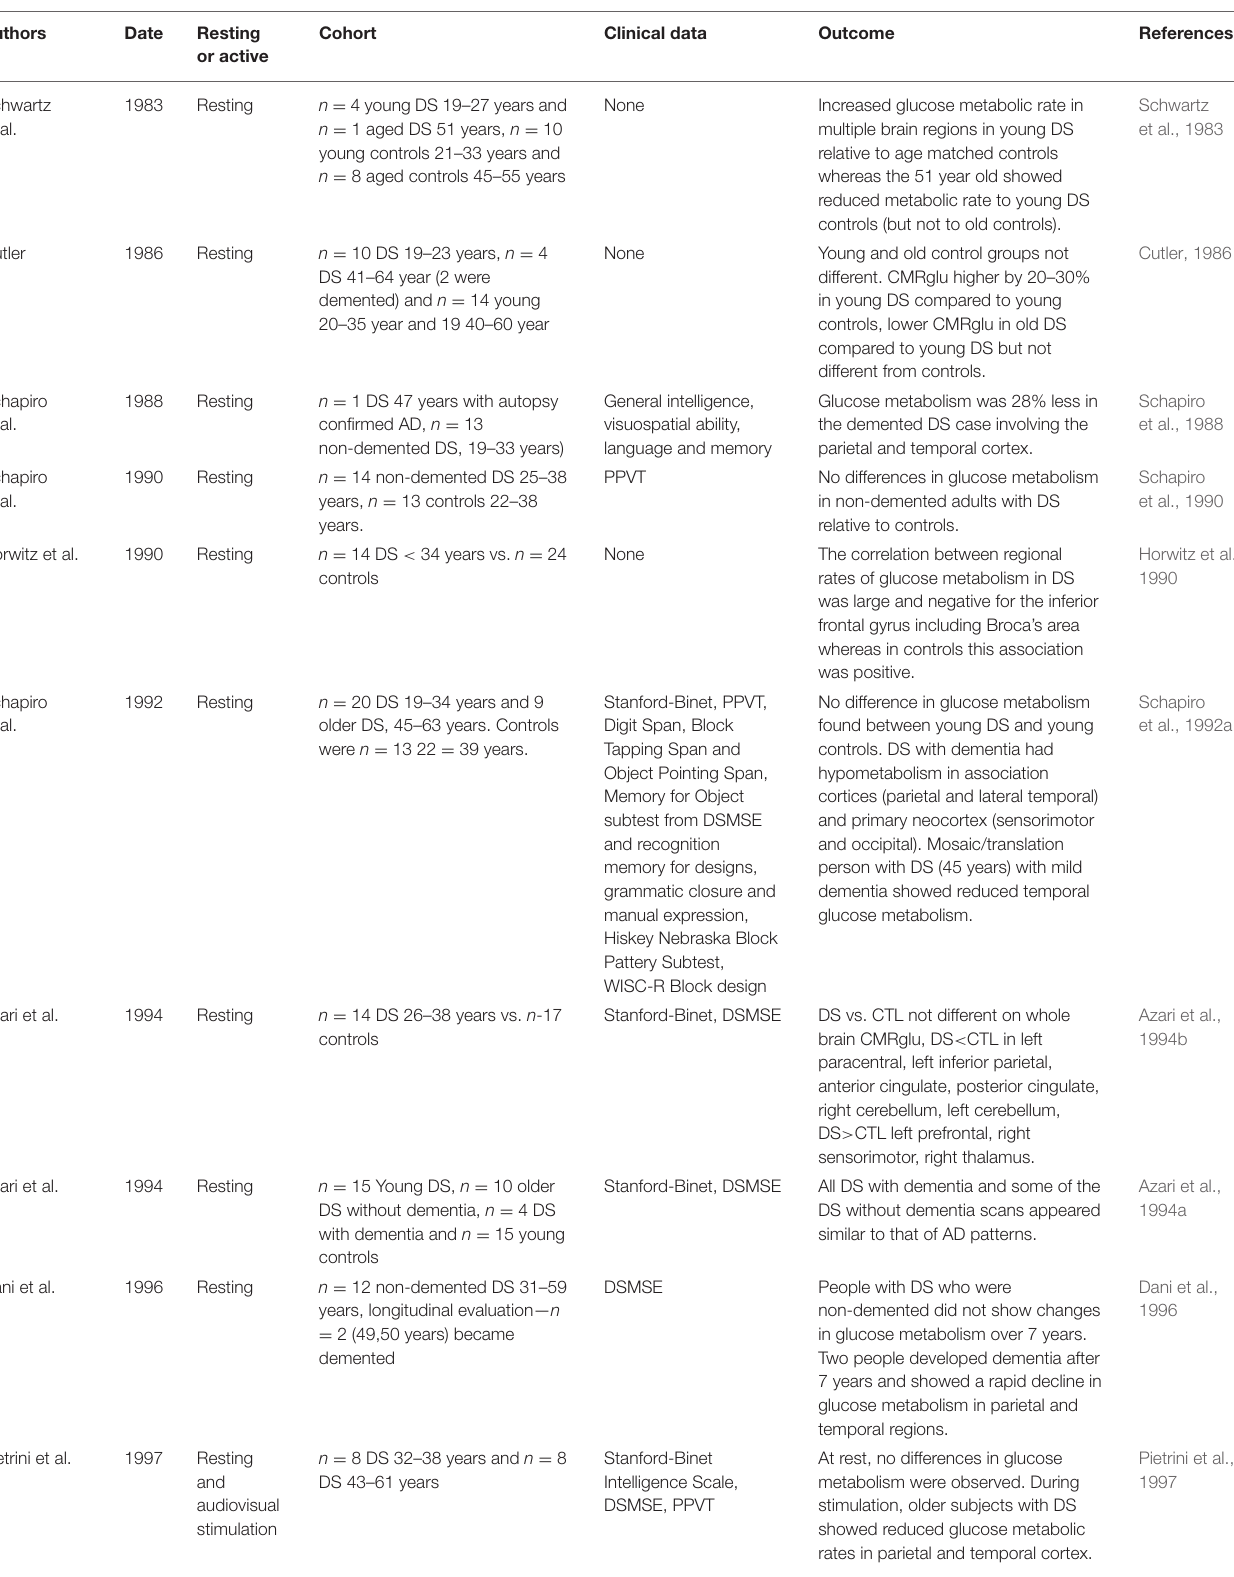
TABLE 1 | Summary of FDG-PET studies in DS (since